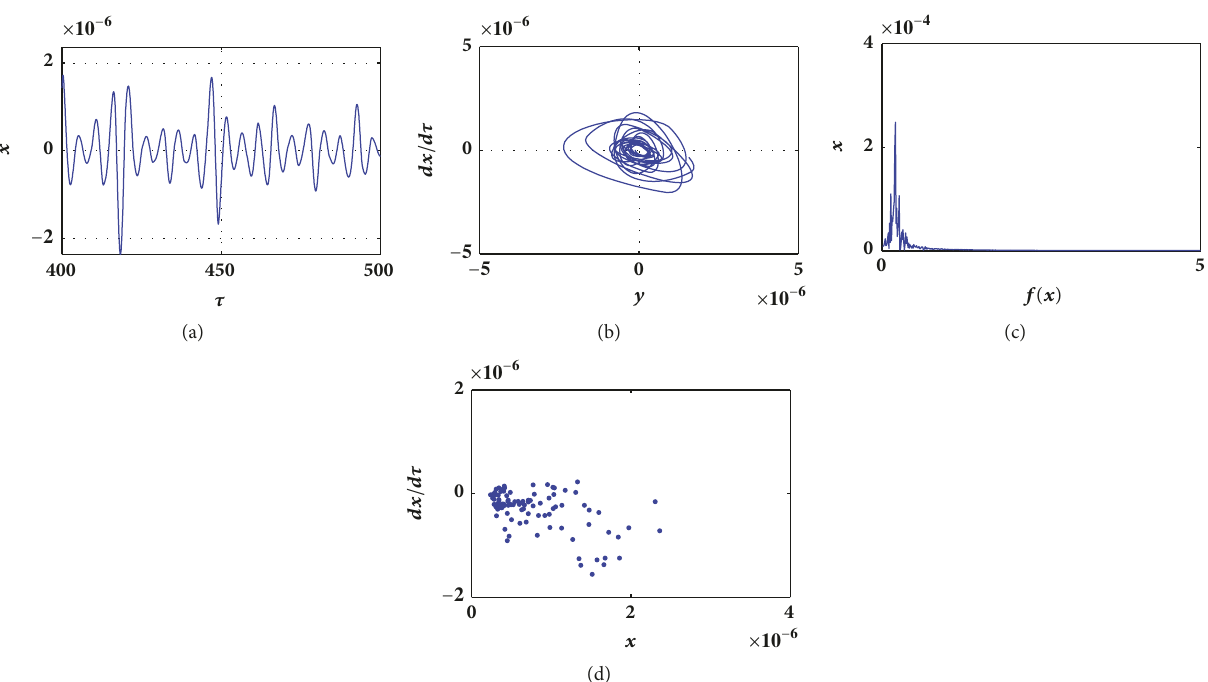
Figure 5: The time history, the phase diagram, spectrum, and the Poincar´e section of the system (6) for 𝜀 = 0.6529 , 𝑄 = 1 .